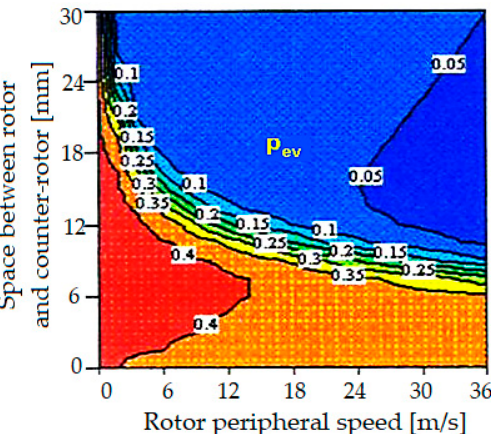
Figure 10. Graphic representation of evacuation losses ( p ev ) as a function of rotor peripheral speed ( v p ) and feed speed ( v a ).